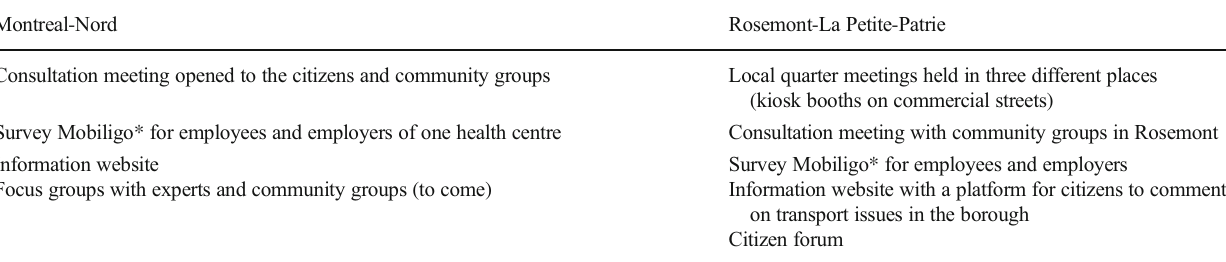
Activities and tools of the participatory processes in Montreal-Nord and Rosemont-La Petite-Patrie